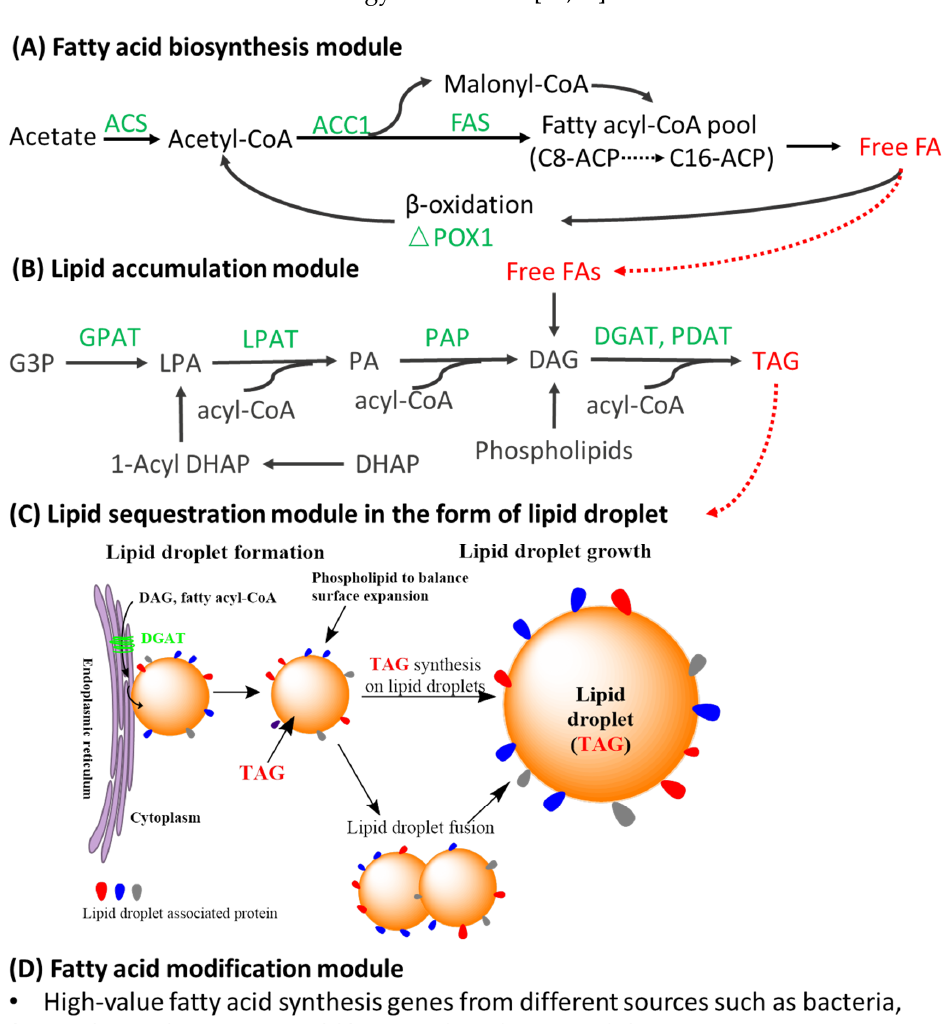
Figure 1. Four modules of lipid biosynthesis in yeast, including ( A ) fatty acid biosynthesis module, ( B ) lipid accumulation module, ( C ) lipid sequestration module in the form of lipid droplet, endoplasmic reticulum budding model of lipid droplet formation and expansion (redrawn with modifications from [29], and ( D ) fatty acid modification module.